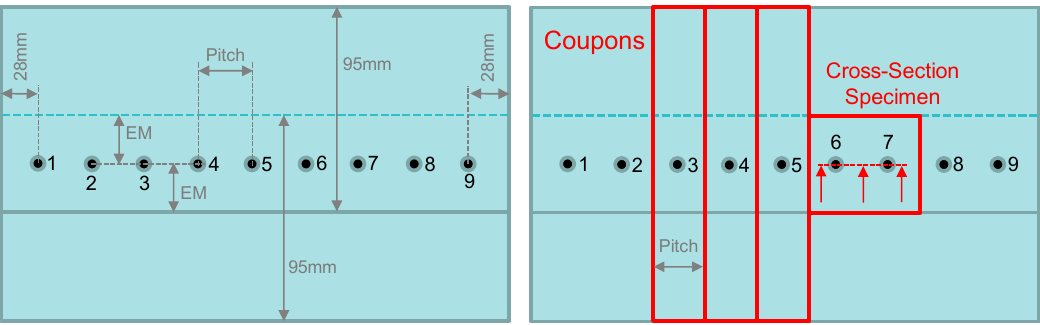
Figure 6. Top views of 9-spot-welded panels: (left) panel configuration; (right) cut plan. The refill spot welds are numbered from left to right. Notes: EM = Edge Margin; pitch = Spot Weld Spacing.